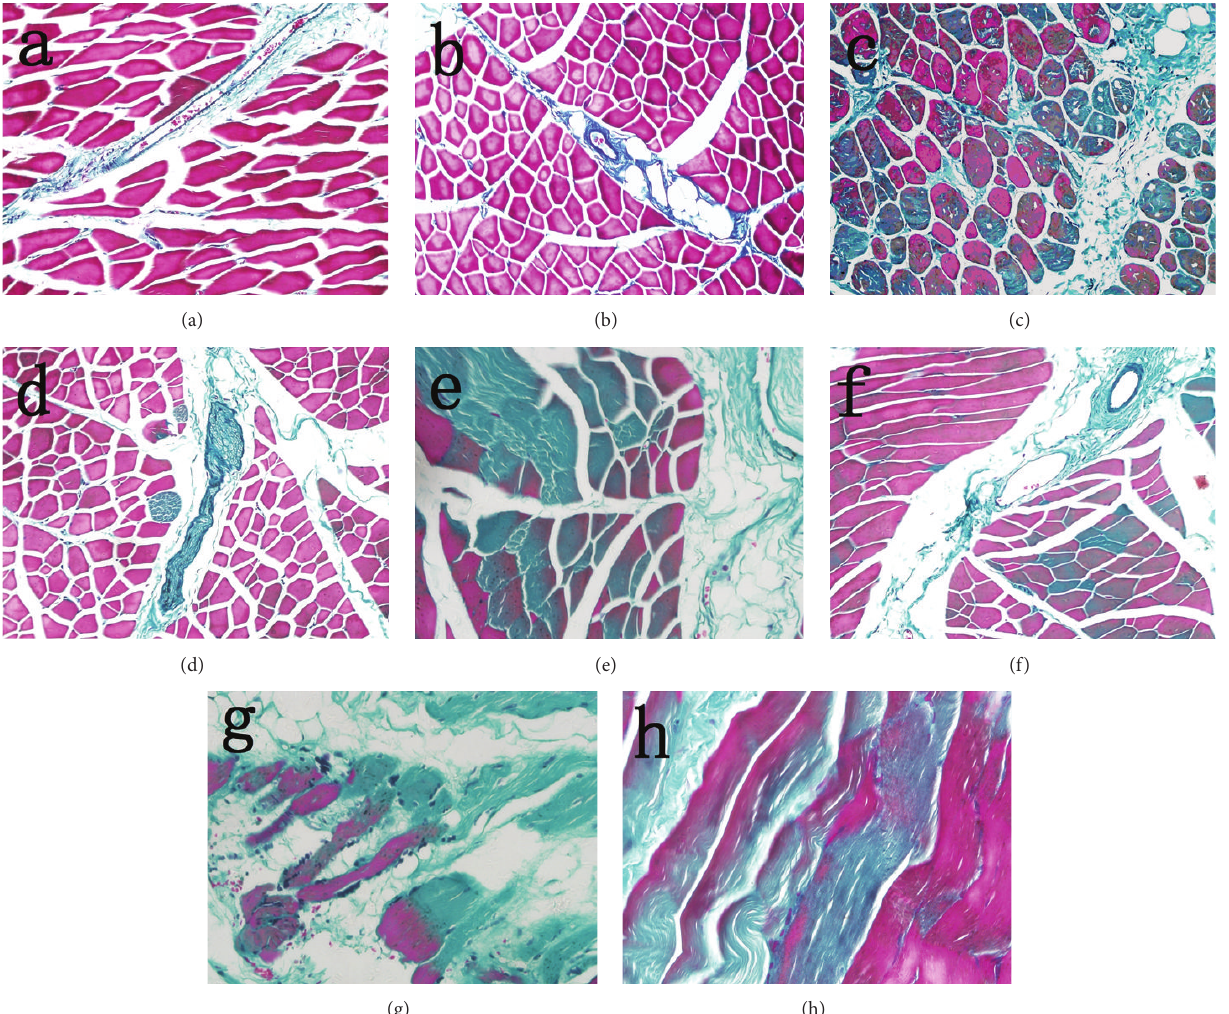
Figure 4: Observation of fibrosis in collagen at different time points after irradiation with Masson staining ( × 200). Slight swelling of muscle cellswasnotedinPBSgroup(a)andASCsgroup(b),andlittlecollagenproliferationwasobservedbetweenmusclecellsat1 wafterirradiation; the swelling of muscle cells and collagen proliferation in PBS group (c) were more severe than those of ASCs group (d) at 4 w after irradiation; the denaturation, necrosis of muscle cells, and collagen proliferation in PBS group (e) showed significant increase compared with those in ASCs group (f) at 8 w after irradiation; significant increase of necrotic muscle cells was noted in PBS group (g) in comparison with ASCs group (h) at 26 w after irradiation. Meanwhile, residual skeletal muscle cells were observed in the proliferative collagen in both